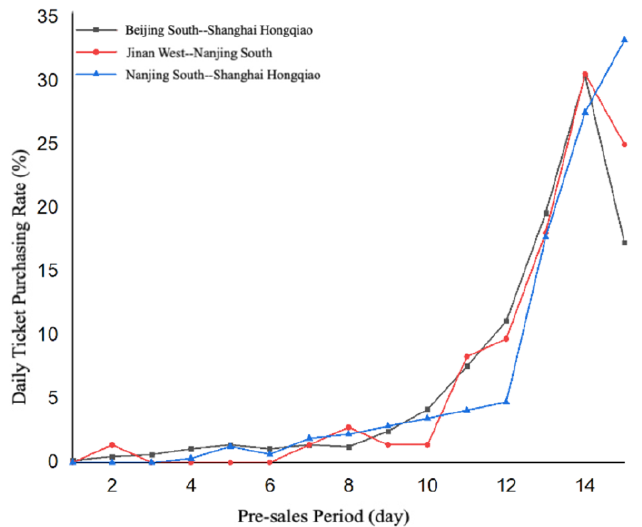
Figure 4. Distribution of daily ticket-purchasing rates in partial OD sections of Beijing–Shanghai HSR.